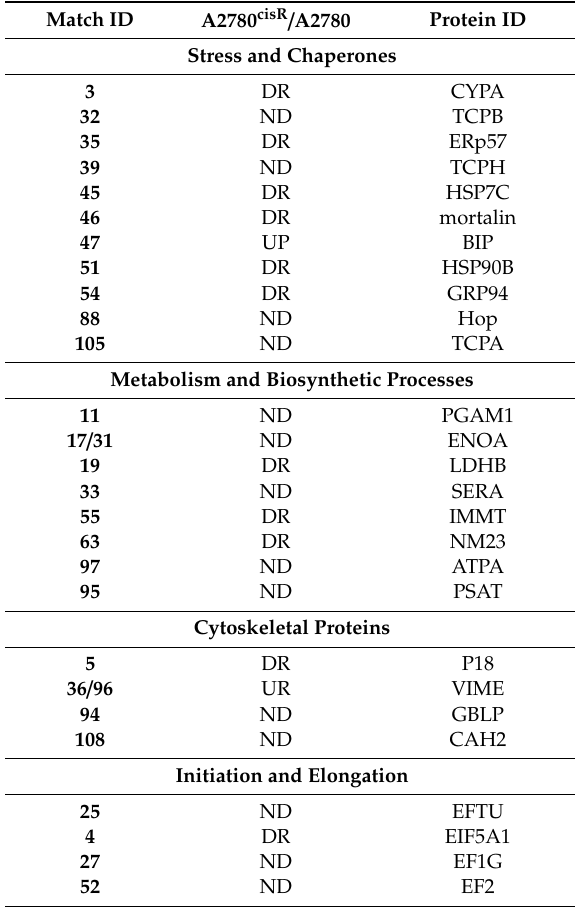
Table 10. Functional classification of the proteins that are di ff erentially expressed in the A2780 cisR cell line compared to the A2780 cell line due to treatment using the parent cell line A2780 as